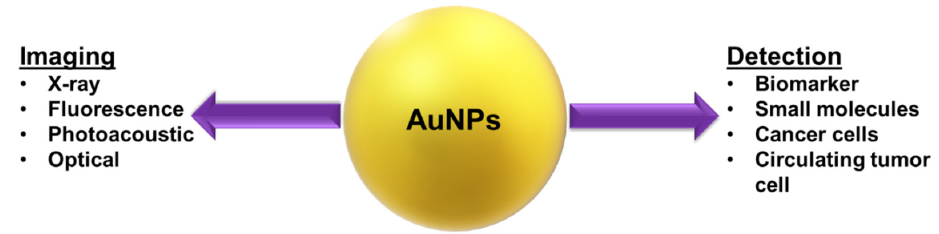
Figure 6. Application of AuNPs for cancer detection and